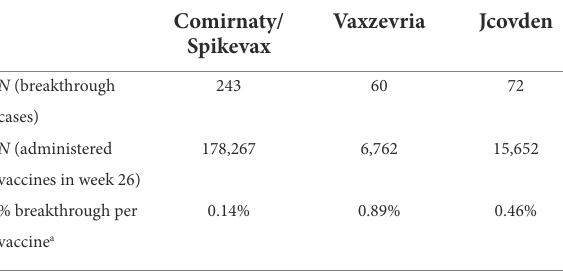
TABLE 2 Overview of breakthrough cases and administered vaccines per vaccine type.